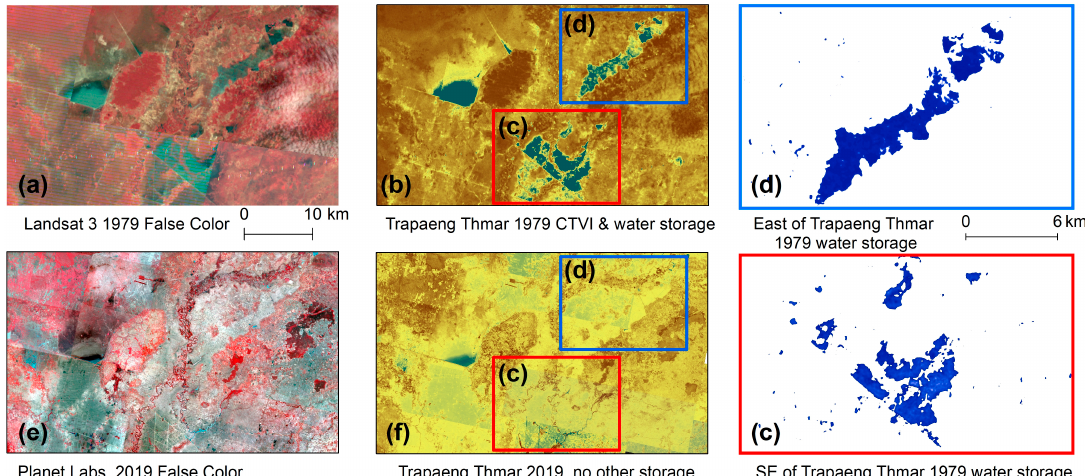
Figure 13. Landsat images (60 m resolution) and Planet Labs imagery (3 m resolution) of the Trapaeng Thmar and Banteay Meanchey water storage areas, from 1979 and 2019, respectively. ( a ) 1979 imagery in false color infrared; ( b ) 1979 CTVI image; ( c ) and ( d ) are close-up images of the 1979 water storage features; ( e ) is the 2019 high resolution false color image, and ( f ) the same imagery, CTVI processed.